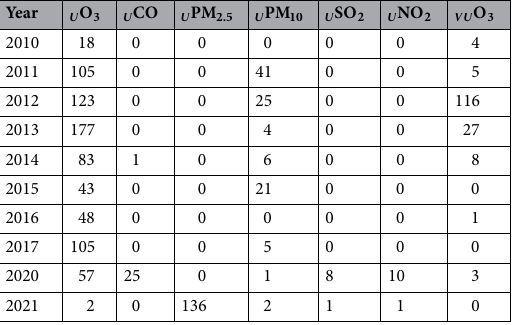
Table 2. Pollutants that affect unhealthy (U) and very unhealthy (VU) days in